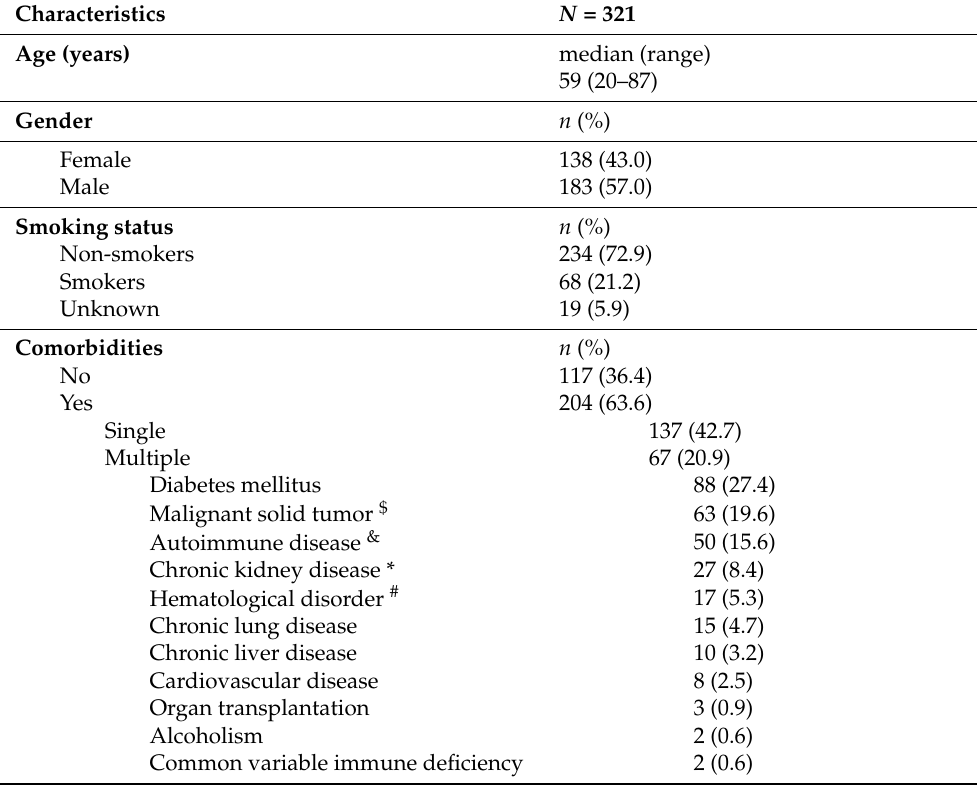
Table 1. Demographic data and patients’